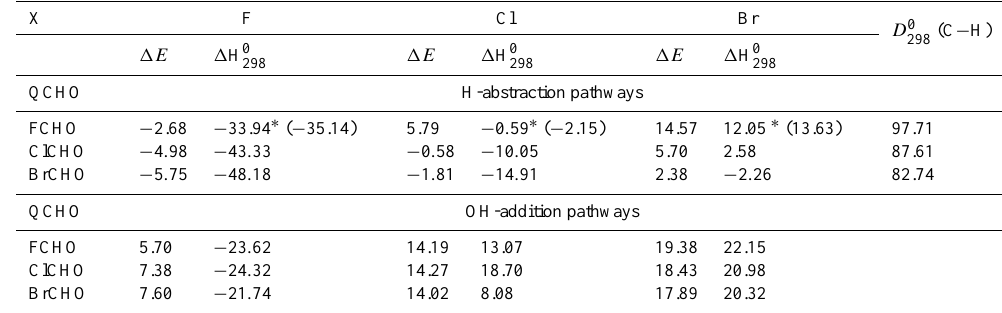
Table 1. Energy parameters, including the potential barrier heights ( 1E ), reaction enthalpies ( 1 H 0 (C − H)] for the title reactions QCHO+X → products (in kcalmol − 1 ).